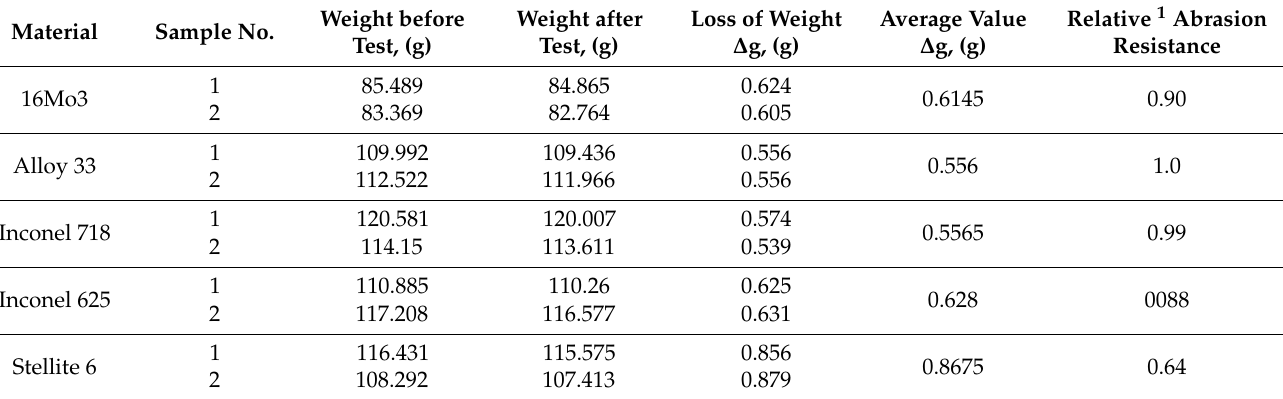
Table 5. The results of the comparison of the abrasive wear of the tested CMT cladded materials. Weight before Material Sample No. Test, (g) Figure 12. Loss of weight of the materials after the abrasive wear test according to ASTM G65.